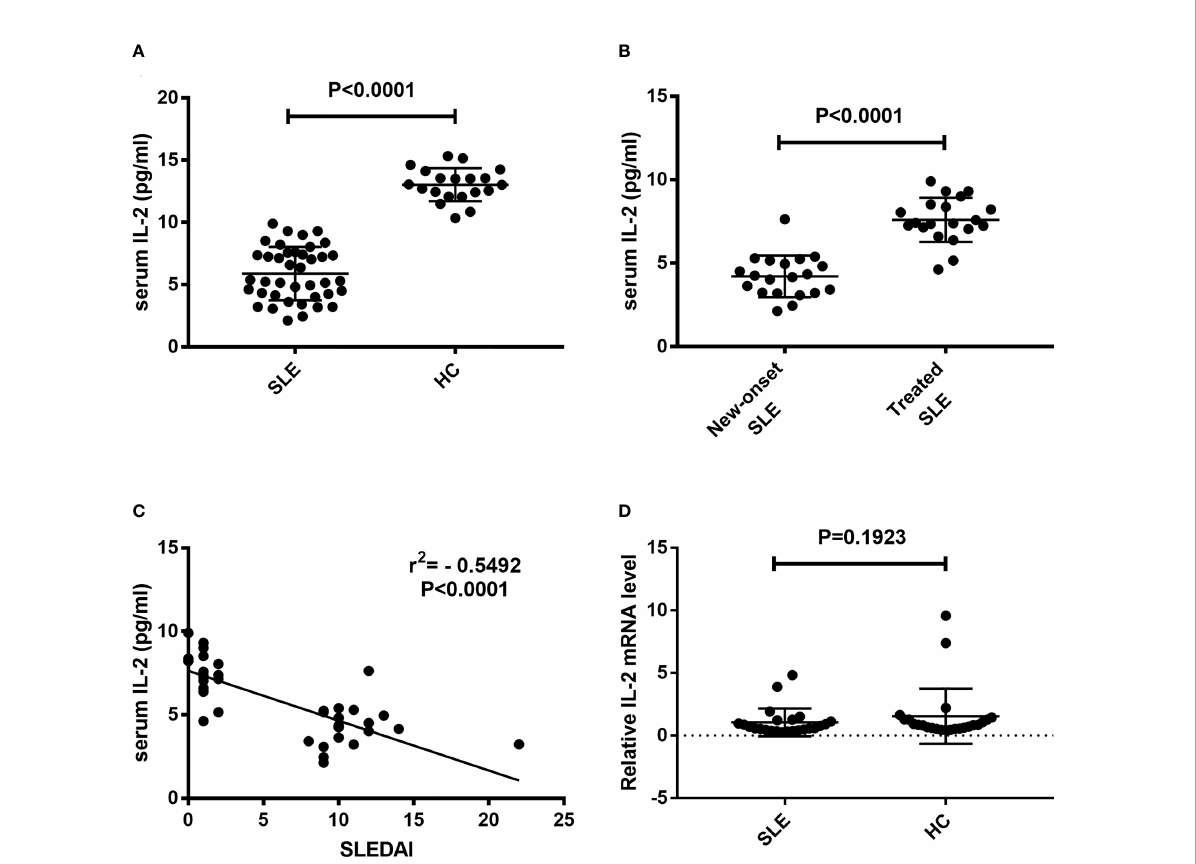
FIGURE 1 Detection of IL-2 levels in peripheral blood of SLE patients. Serum IL-2 levels and relative IL-2 mRNA levels in CD3 + T cells were detected and compared between SLE patients and HCs. (A) Serum IL-2 levels in SLE patients was signi fi cantly decreased than those in HCs. (B) Serum IL-2 levels in new-onset SLE patients was signi fi cantly decreased than those in treated SLE patients. (C) A negative correlation was observed between serum IL-2 levels and SLEDAI. (D) No signi fi cant difference was found in the IL-2 mRNA levels of CD3 + T cells between SLE patients and HCs. SLE, systemic lupus erythematosus; HCs, healthy controls; SLEDAI, Systemic Lupus Erythematosus Disease Activity